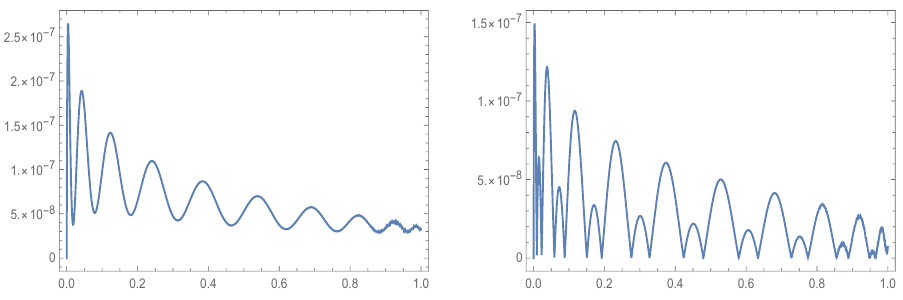
Figure 11. MAE of Z N ( x ) of our algorithm for υ 1 = 0.5 and N = 20 with b = 0 (figure at left ) and b = 3 (figure at right ) for Example